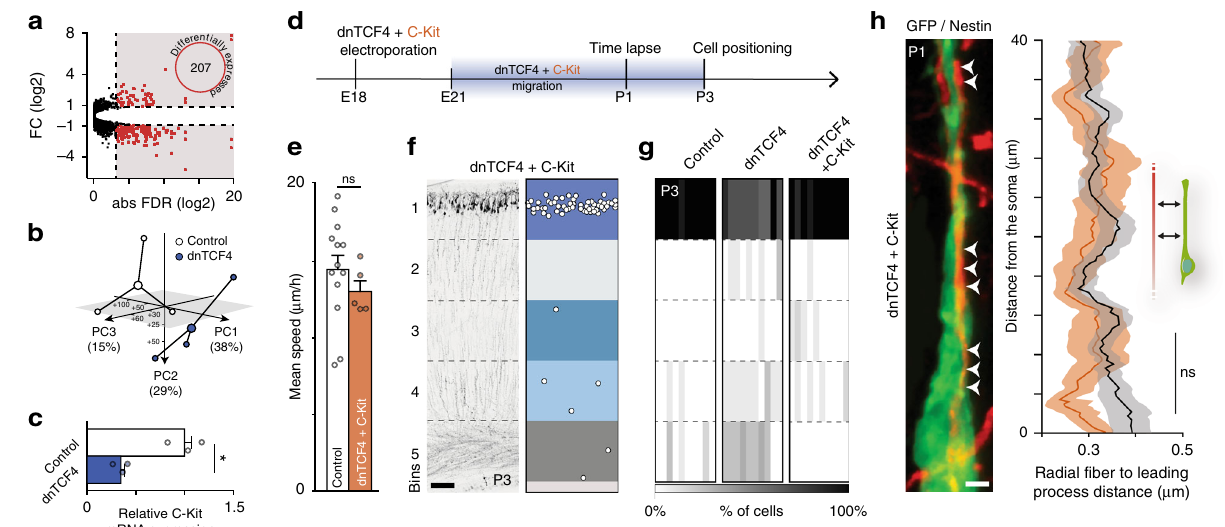
Fig. 3 Wnt LOF perturbs leading process-radial fi ber interactions via C-kit. a RNA sequencing identi fi ed 207 differentially expressed genes (DEGs) between control and dnTCF electroporated migrating neurons (selection by fold change (FC) of > 0.9 and < − 0.9 and false discovery rate (FDR) of ≤ 0.1). b Three independent experiments plotted by principal components (PC) from PC analysis based on DEGs in control and dnTCF4 migrating neurons. See also Supplementary Table 1. c Relative C-Kit mRNA expression quanti fi ed by qRT-PCR on sorted migrating cells at P0 from control and dnTCF4 electroporated brains; n = 3 experiments, Student ’ s t test. d Timeline of rescue experiments with transient dnTCF4 and C-Kit co-expression during migration. e C-Kit overexpression during migration restores locomotion speed; n = 13 and fi ve brains (Control and dnTCF4 + C-Kit, respectively), Mann – Whitney, P = 0.1734. f C-Kit overexpression reduces the proportion of delayed neurons represented in coronal section from a dnTCF4 + C-Kit electroporated brain at P3. g Heatmap of P3 cortical cell distribution, color-coded columns represent n = 10 brains per condition. h Representative image illustrating migrating cells attached to nestin-positive radial glia fi bers. C-Kit overexpression in migrating cells restores a normal adhesion to the radial glia (arrowheads). Point-by- point measurement of the distance between the leading process of migrating cells and the radial fi ber; n = 50 cells per condition from 4 brains, two-way ANOVA, P = 0.1231. Graphs display mean ± s.e.m. ns, non-signi fi cant, * P < 0.05. Bar = 2 μ m ( h ) and 100 μ m ( f